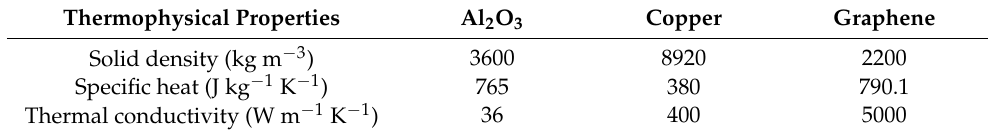
Table 2. Thermophysical properties of nanoparticles, including Al 2 O 3 , copper and graphene [26]. Thermophysical